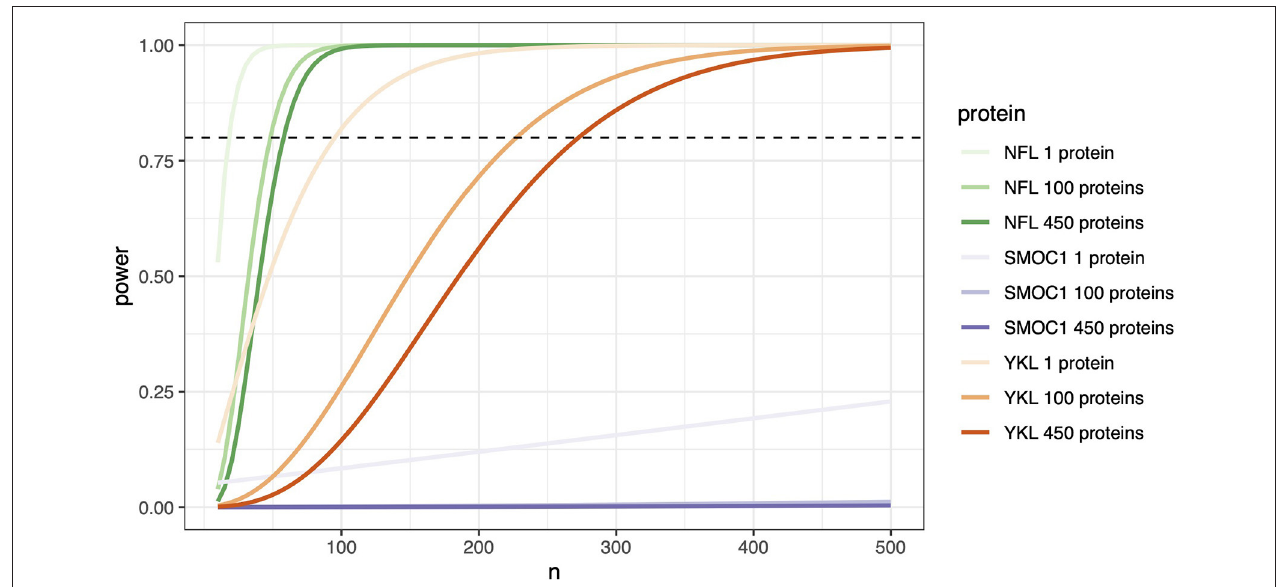
FIGURE 7 | Protein effect size determines the number of samples needed. Stringent significance thresholds are necessary when measuring multiple proteins in parallel. Protein effect size becomes a significant determinant of the number of samples required to achieve confidence in any observed differences. A two-sample t- test power calculation on each individual’s baseline data ( n = 34 cognitively unimpaired and n = 20 AD) was used to simulate experimental power. Number of samples required in experiments measuring a single protein, 100 proteins, and 450 proteins were calculated. Significance values used corresponded to Bonferroni corrected p -values, 0.05 for a 1 protein experiment, 0.0005 for 100 proteins, and 0.0001 for 450 proteins. The power threshold of 80 % is represented here with the horizontal dashed line. In this model, proteins with significant effect sizes, such as NfL, can achieve 80% power in a single protein experiment with close to 30 samples per group, increasing only to 100 samples in an experiment measuring 450 proteins. In contrast, a protein with a moderate effect size such as MCP-1 requires an n = 170 when measured alone, n = 400 if measuring n = 100 proteins, and just under 500 in an experiment of 450 proteins. SMOC1, even with 500 samples, fails to reach 80%